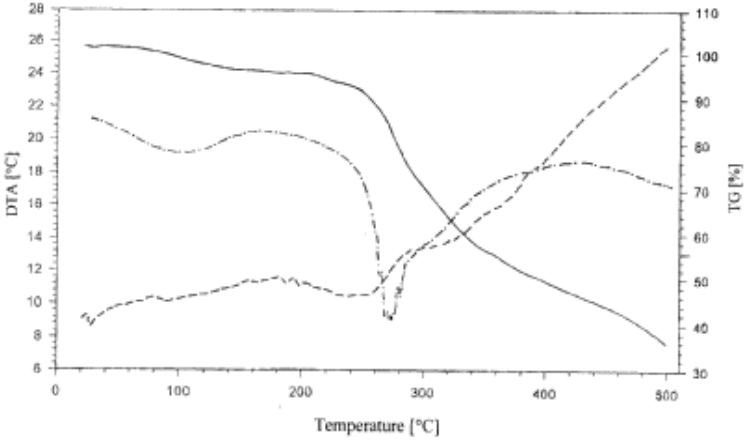
Figure 4. Thermogram (TG, DTG, DTA) of GPWCS in the 25-500 o C